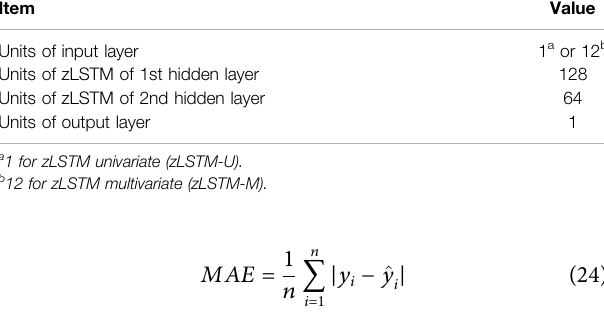
TABLE 1 | Hyper parameters of zLSTM model.